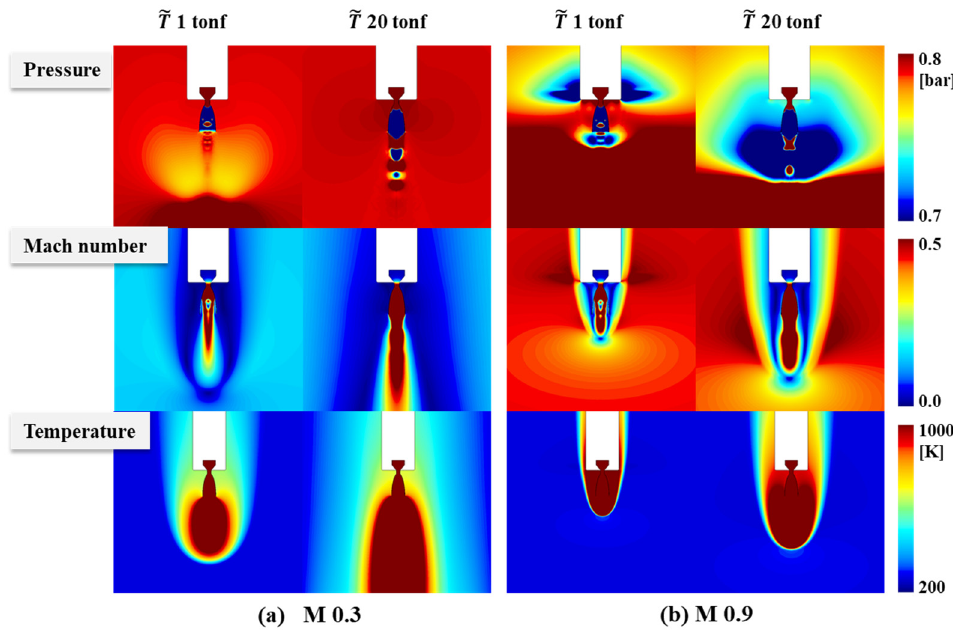
Figure 11. Flowfield at different Mach numbers and thrust values. ( a ) Flowfields at Mach number of 0.3; ( b ) Flowfields at Mach number of 0.9.